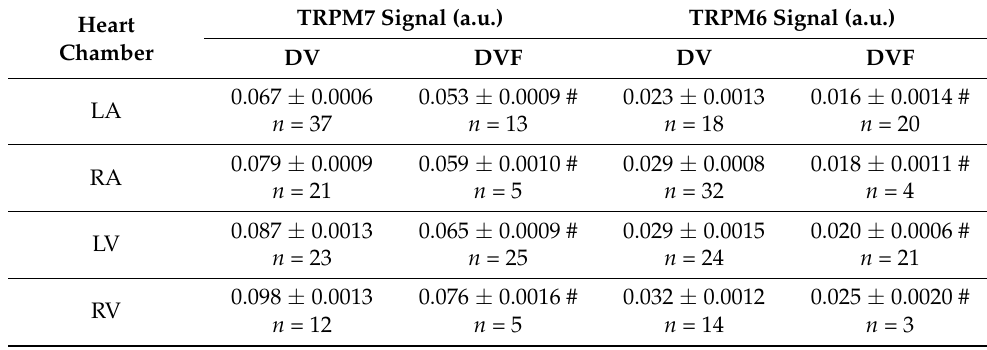
Table 1. Immunofluorescence signals of the TRPM7 and TRPM6 proteins in pig hearts. TRPM7 Signal (a.u.) Heart Chamber